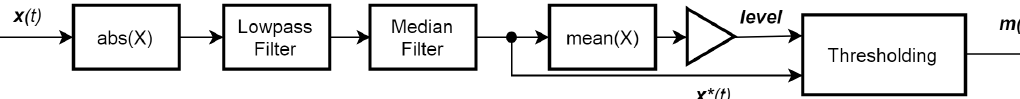
Figure 5. The scheme of detection block.